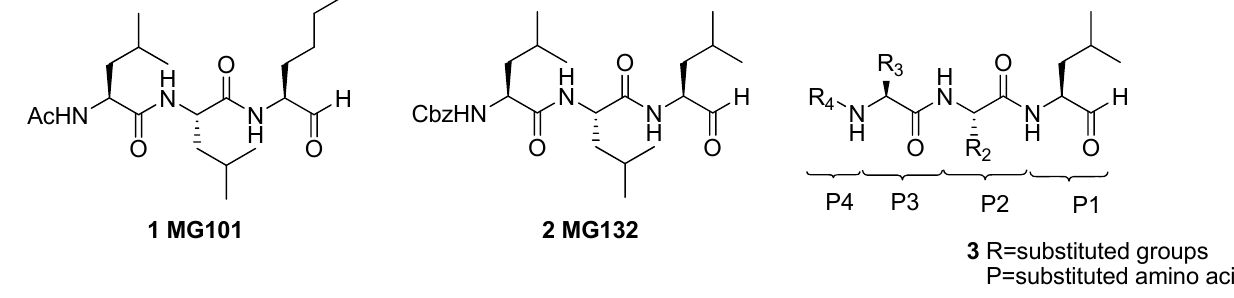
Figure 1. Structures of MG101 ( 1 ), MG132 ( 2 ) and peptide aldehydes ( 3